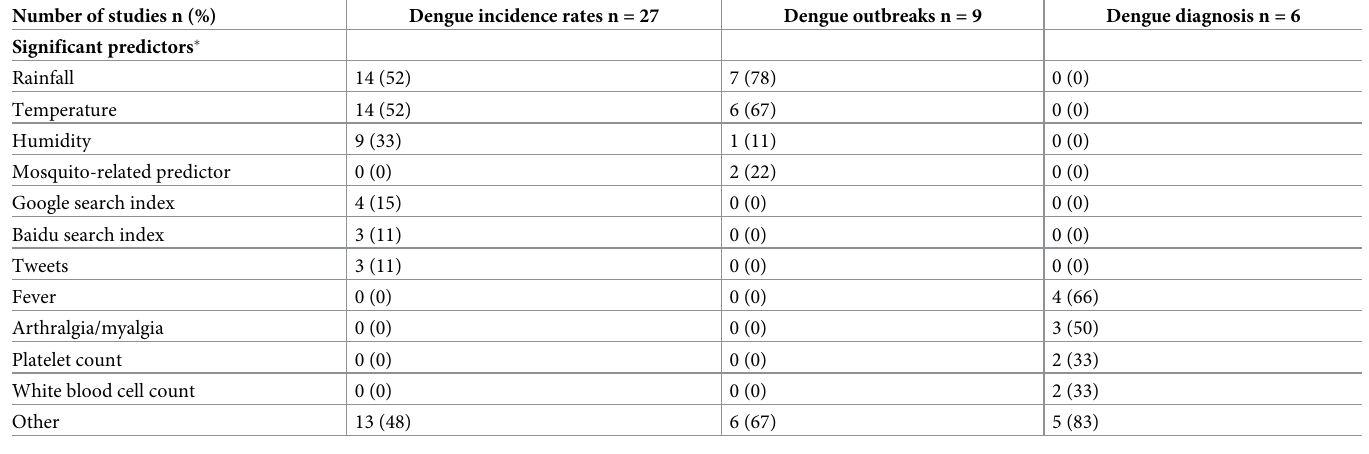
Table 5. Most significant predictors for the three most frequently studied